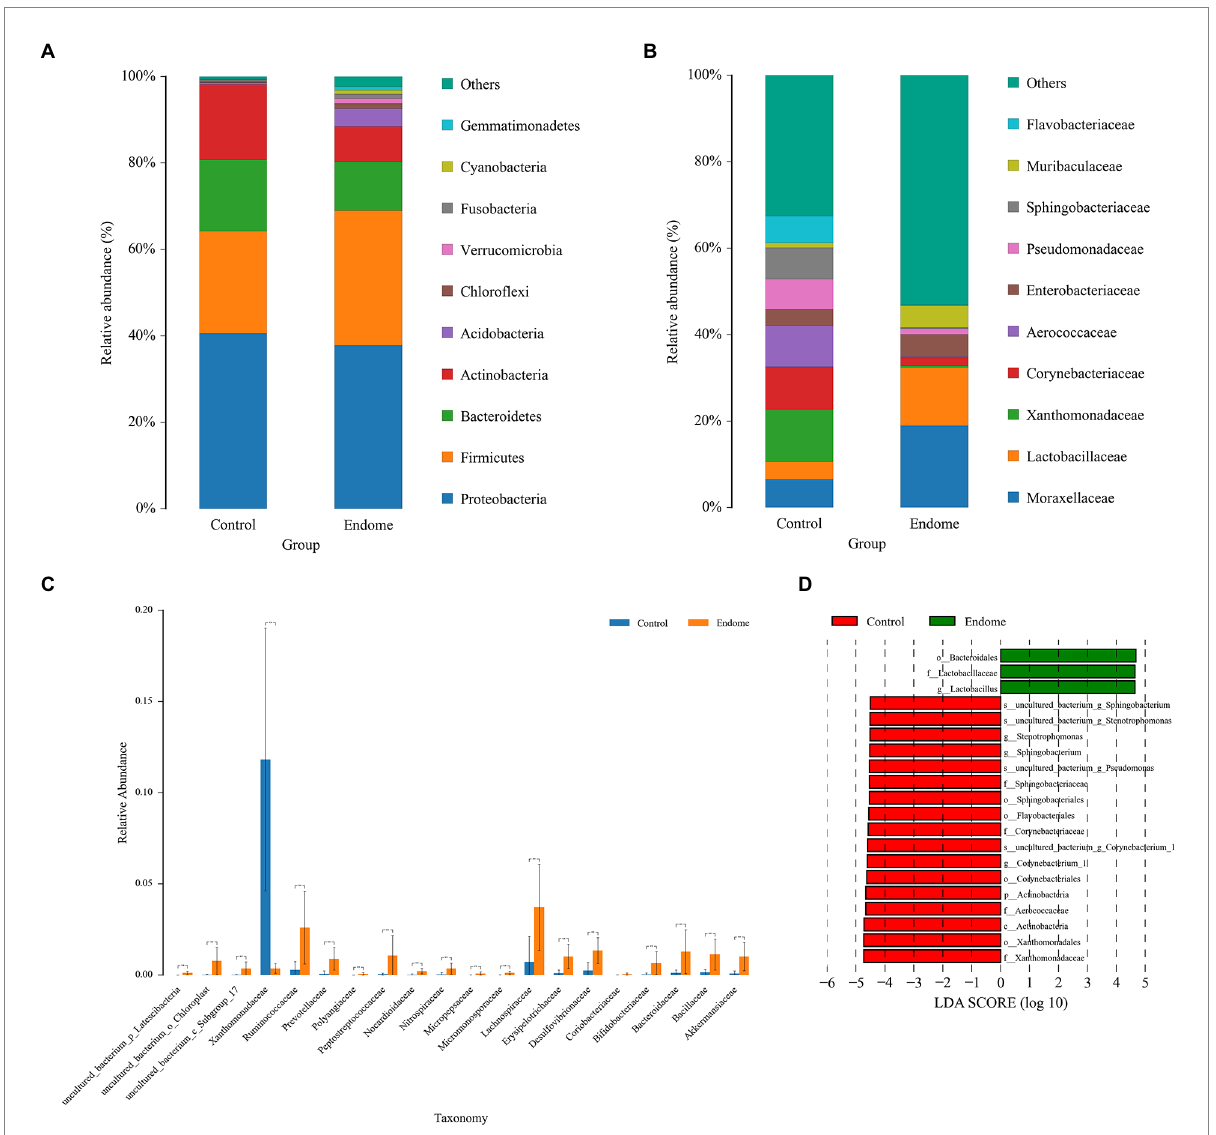
FIGURE 4 Bacterial taxon sequencing analysis of vaginal microbiota in donkey jennies of group C and group E. (A) Relative abundance of OTUs at the phylum level of the two groups. (B) Relative abundance of OTUs at the family level of the two groups. (C) ANOVA of vaginal microbiota at the family level between group E and group C. Blue bars represent group C, and orange bars represent group E. **Significant difference ( p < 0.01; Mann–Whitney U test). (D) Linear discriminant effect size analysis (LEfSe) of the vaginal microbiota of healthy and endometritis donkeys. Bacterial taxa at the genus level and higher in group C (healthy donkeys, in red) and group E (endometritis donkeys, in green) were illustrated by LDA scores >